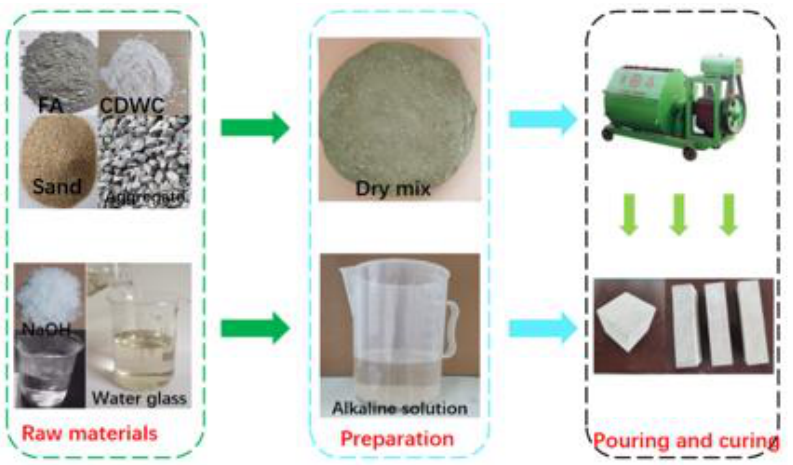
Figure 2. Schematic diagram of specimen